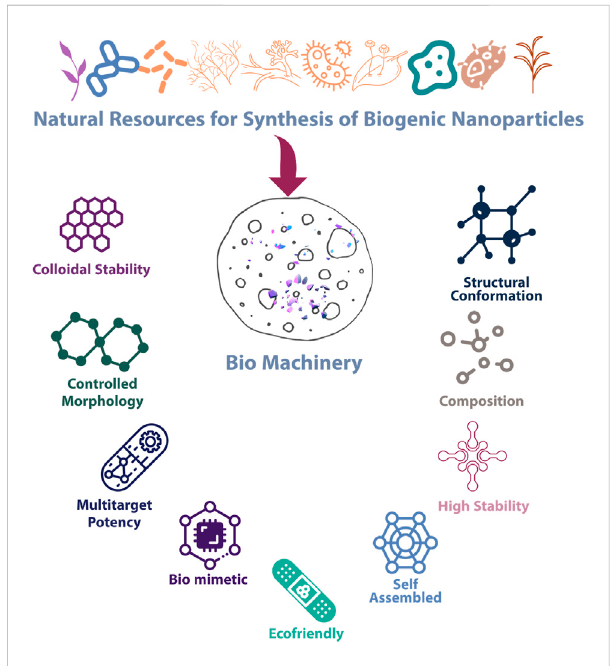
FIGURE 1 Salient features and properties of biogenic